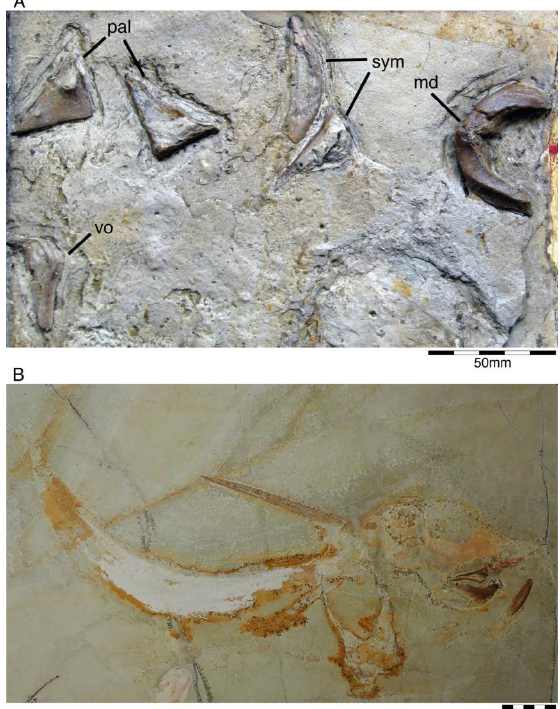
Figure 3. † Chimaeropsis paradoxa von Zittel, 1887 [89]. ( A ) Fragmentary cranial remains (SNSB-BSPG AS I 1330) consisting mainly of dental parts from the early Tithonian of Solnhofen. This specimen was figured by von Meyer in Münster [50] (pl. 8, figure 1) and Riess [93] (pl. 3, figure 10). Abbreviations: md, mandibular tooth plates; sym, symphyseal tooth plates; pal, palatinal tooth plates; vo, vomerine tooth plate. ( B ) Holomorphic specimen (LF 2317) from the early Tithonian (Upper Jurassic) of Eichstätt. This specimen also was figured by Duffin et al. 98 (figure 9C). Photo provided and reproduced with permission by B. Lauer (Lauer Foundation for